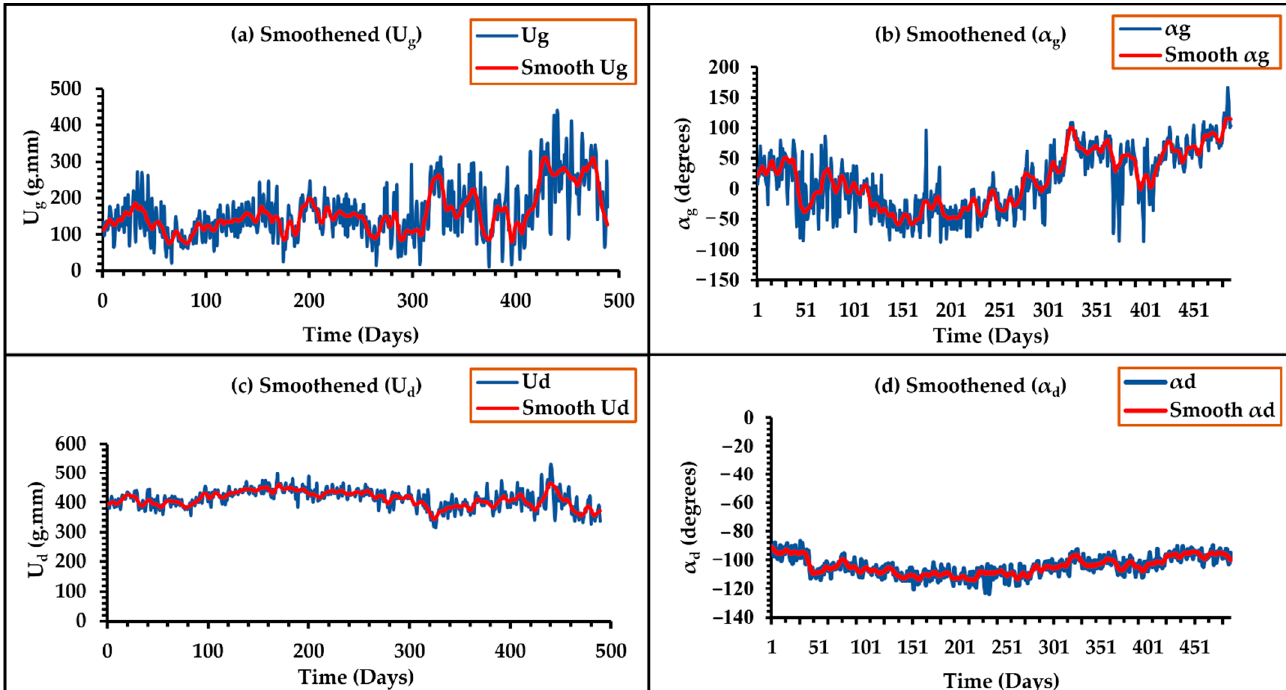
Figure 4. Smoothened datasets of ( a ) U g ( b ) α g ( c ) U d ( d ) α d . Table 1. Hyperparameters taken into consideration for different models. Model Hyperparameters Values ES Smoothing